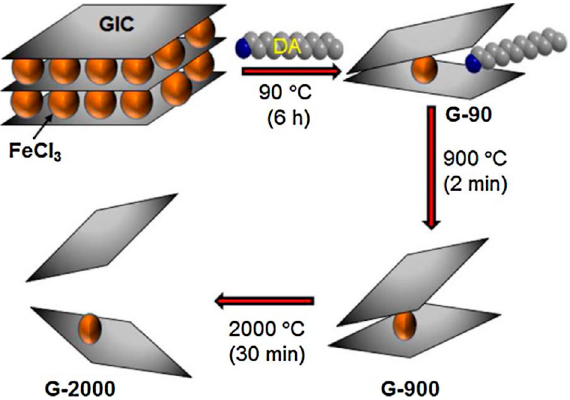
Figure 27. Schematic representation of the production of G-2000. GIC: graphite intercalated compound; DA: dodecylamine. Reproduced from [124]. Copyright Elsevier, 2018.